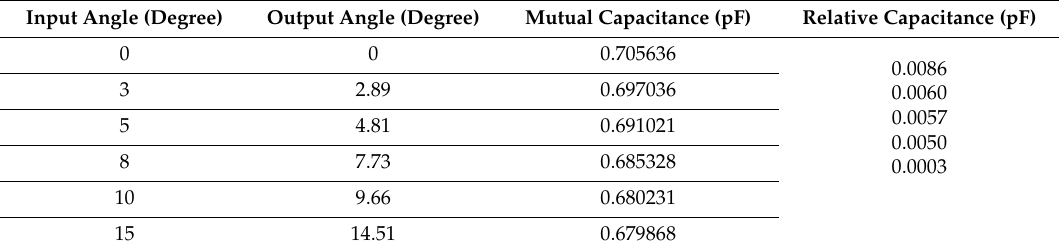
Figure 14. The dynamic experiment test bench. Table 5. The relationship between the angle and the mutual capacitance.